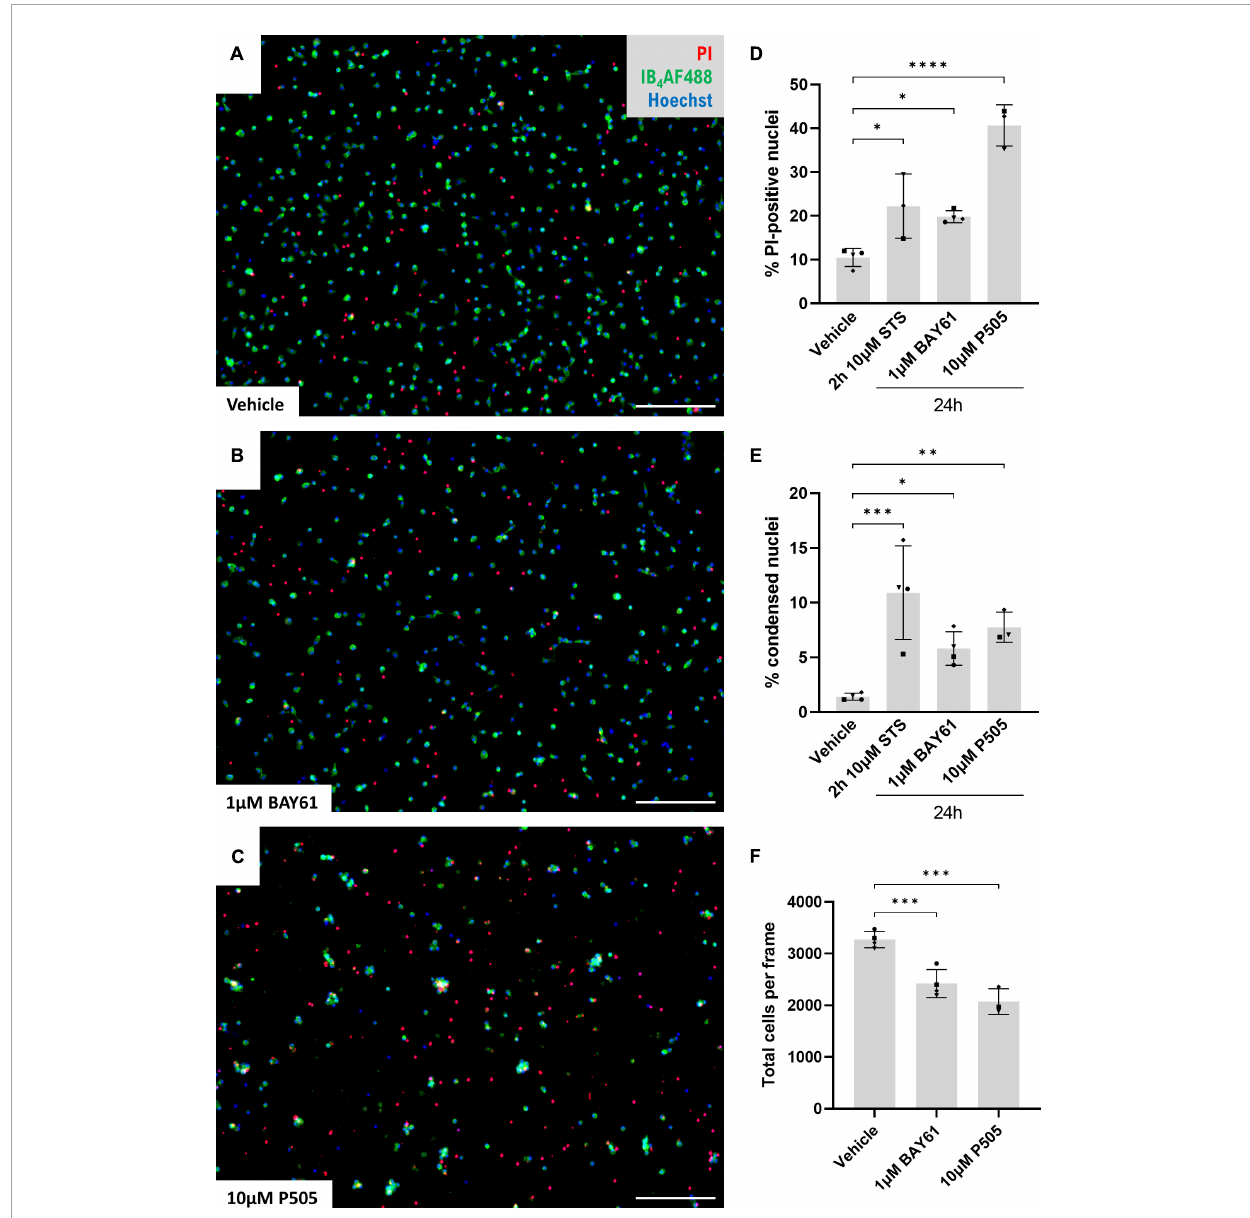
FIGURE4 Microglial cell death is induced by Syk inhibitors. (A–C) Representative 10 × images (cropped) of primary rat cortical microglia treated with ± BAY61 (1 µ M) or ± P505 (10 µ M) for 24 h and stained with Hoechst, IB 4 -AF488, and propidium iodide (PI). Scale bars = 100 µ m. (D) Average percentage PI-positive nuclei in images of primary rat cortical microglia treated with BAY61 (1 µ M) or P505 (10 µ M) for 24 h, or staurosporine (10 µ M) for 2 h. (E) Average percentage condensed nuclei in images of primary rat cortical microglia treated with BAY61 (1 µ M) or P505 (10 µ M) for 24 h, or staurosporine (10 µ M) for 2 h. (F) Average total cells in images of primary rat cortical microglia treated with BAY61 (1 µ M) or P505 (10 µ M) for 24 h. All panels: each datapoint represents the mean of three technical replicates. Number of biological repeats = number of datapoints per column. ∗ p < 0.05, ∗∗ p < 0.01, ∗∗∗ p < 0.001, ∗∗∗∗ p < 0.0001. RM mixed-effects analysis with Dunnett’s post-hoc